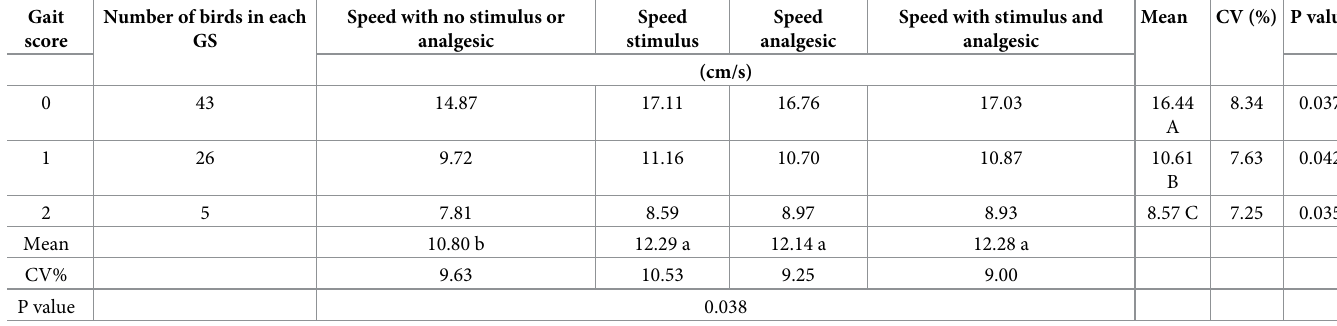
CV: coefficient of variation. Means followed by different capital letters in the columns and different small letters on the row differ according to Tukey’s test at 5%